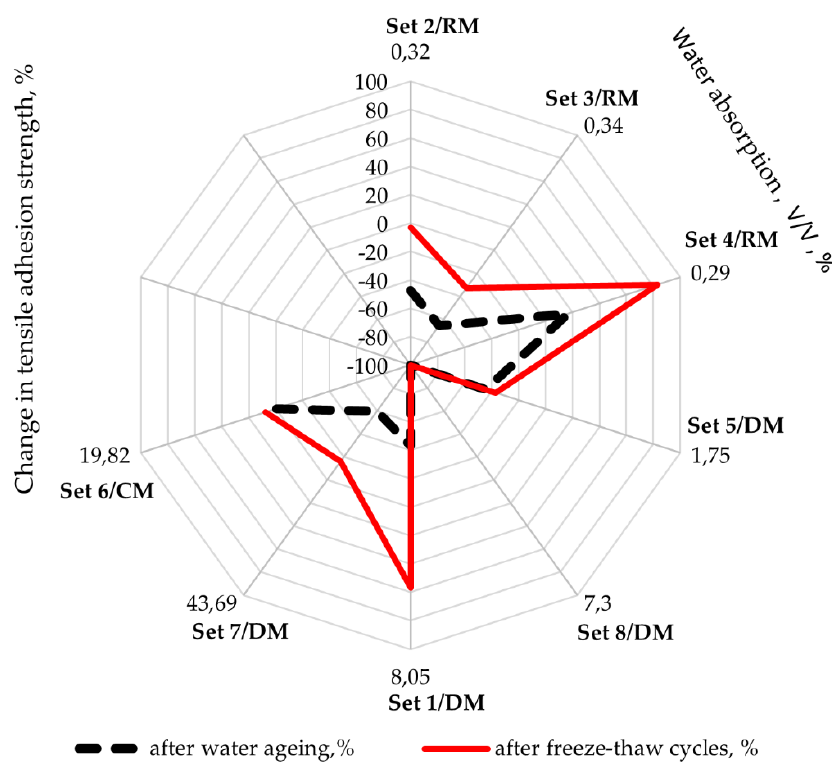
Figure 7. Relationship between a change in the test set tensile adhesion strength following water impact and water absorption of coating absorbability, in V / V%. DM—waterproof coating made of dispersion liquid-applied products, RM—waterproof coating made of reaction resins, CM—waterproof coating made of cementitious mortars.